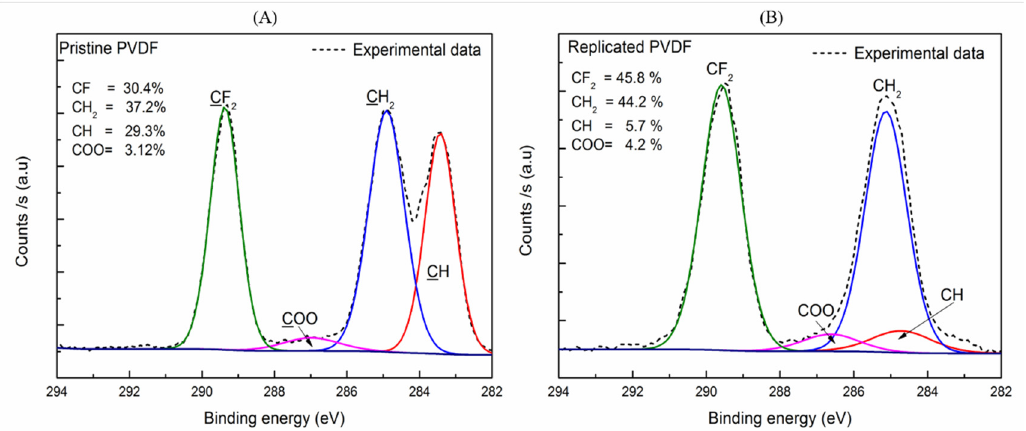
Figure 4. X-Ray photoelectron spectroscopy (XPS) high resolution spectra scan of C1s (carbon components): ( A ) Pristine PVDF and ( B ) Replicated PVDF (green CF2, blue CH2, red CH, pink COO) .